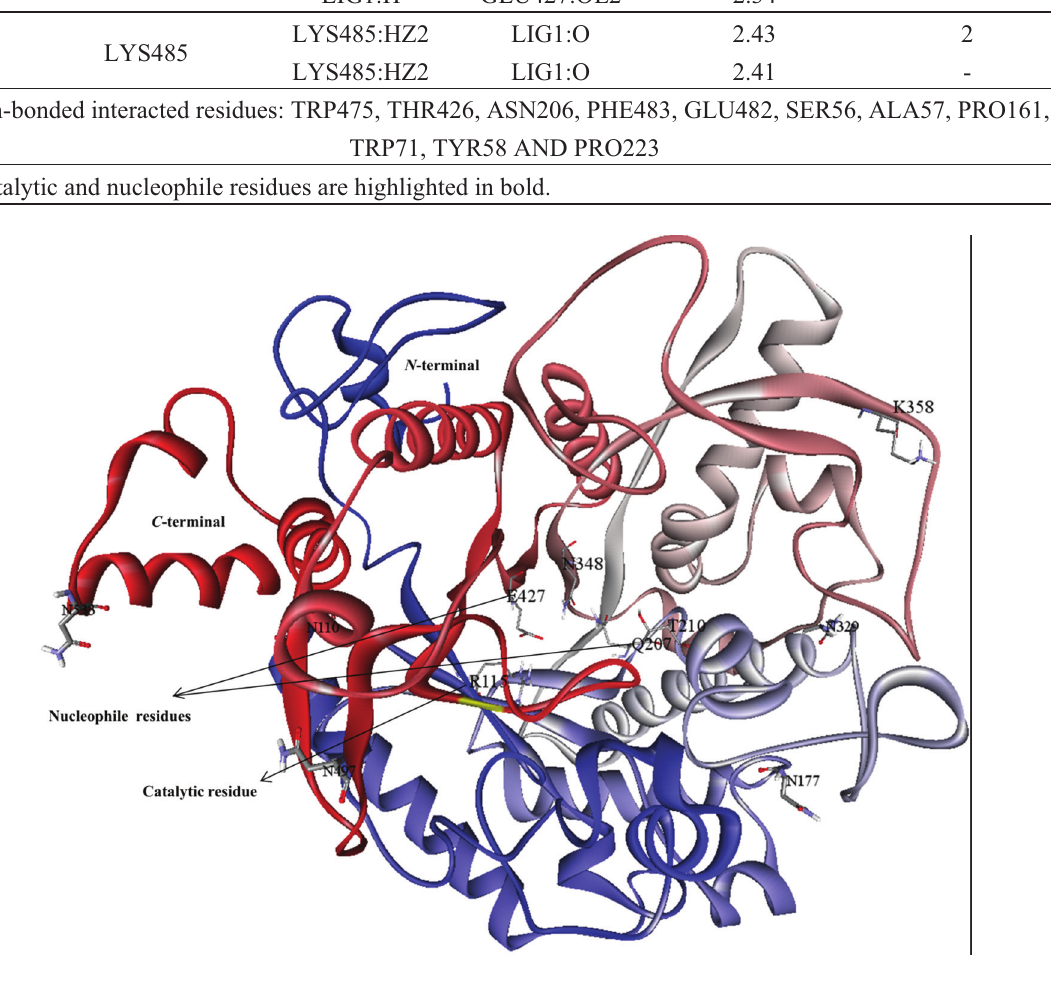
Figure 4. Three-dimensional structure of modeled myrosinase from Brassica oleracea . This figure was generated using DS 3.5 visualizer and colors of N-to-C terminal are based on their secondary